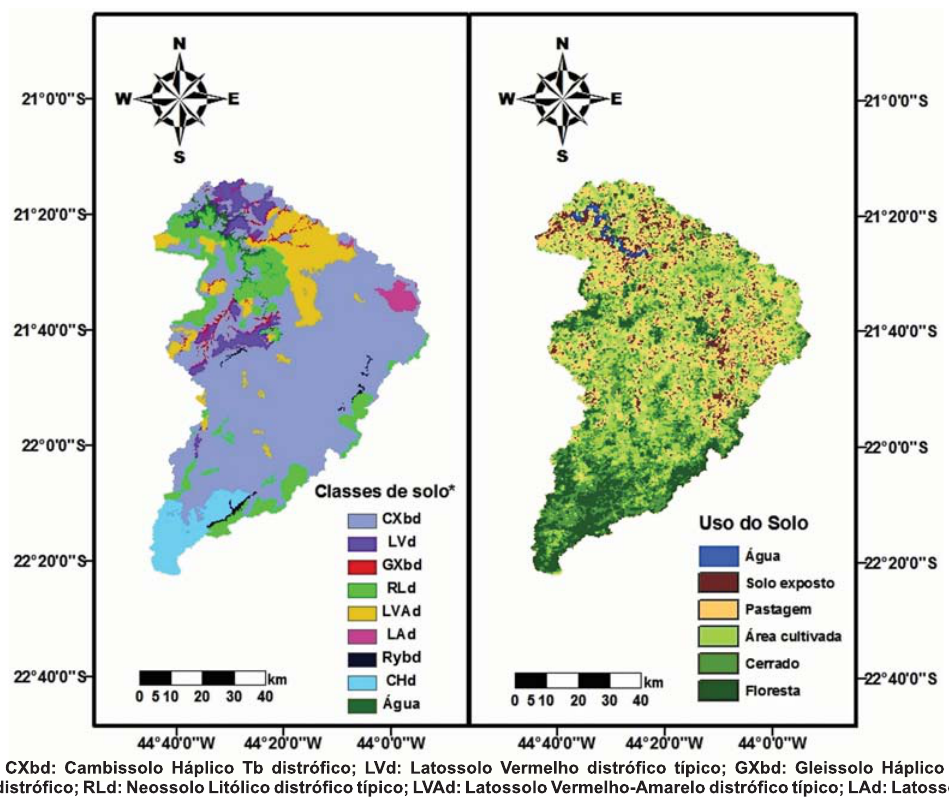
Figura 1. Mapas de solos (a) e uso do solo (b) da Bacia Hidrográfica do Alto Rio Grande. Fonte: Adaptados de Araújo (2006) e Beskow et al.